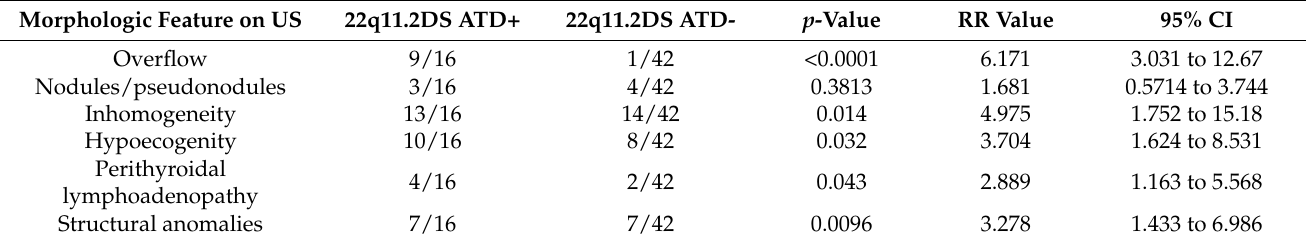
Table 3. Thyroid Morphological Ultrasound Features in 22q11DS